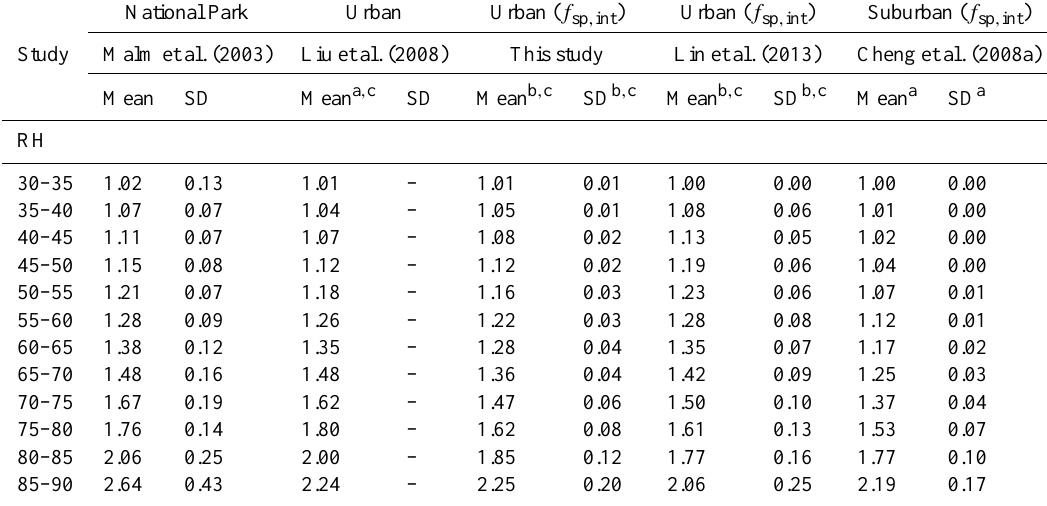
Table 6. Comparison between f sp (RH) obtained in this study and those reported in previous studies. National Park Urban Urban ( f sp , int ) Urban ( f sp , int ) Suburban ( f sp , int ) Study Malm et al. (2003) Liu et al. (2008) This study Lin et al. (2013) Cheng et al.